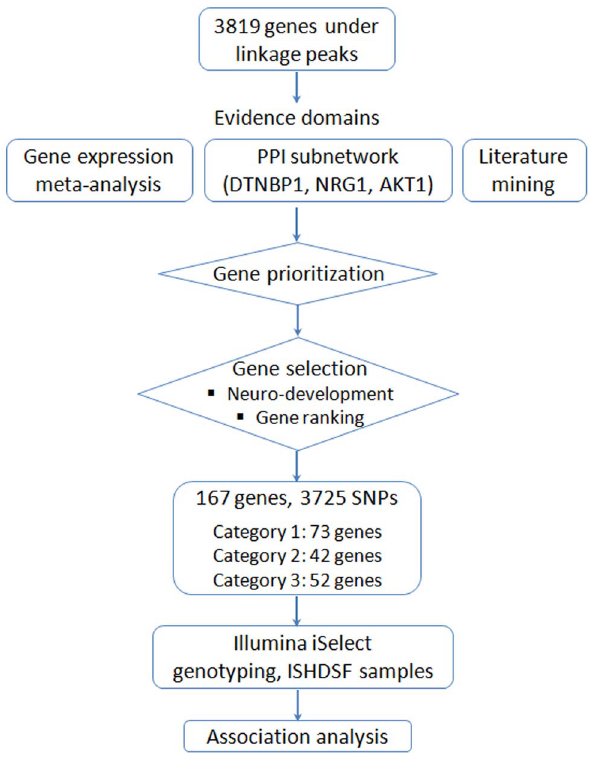
Figure 1. Flowchart of data process, algorithm for gene ranking and selection, custom-based genotyping and associ- ation analysis.